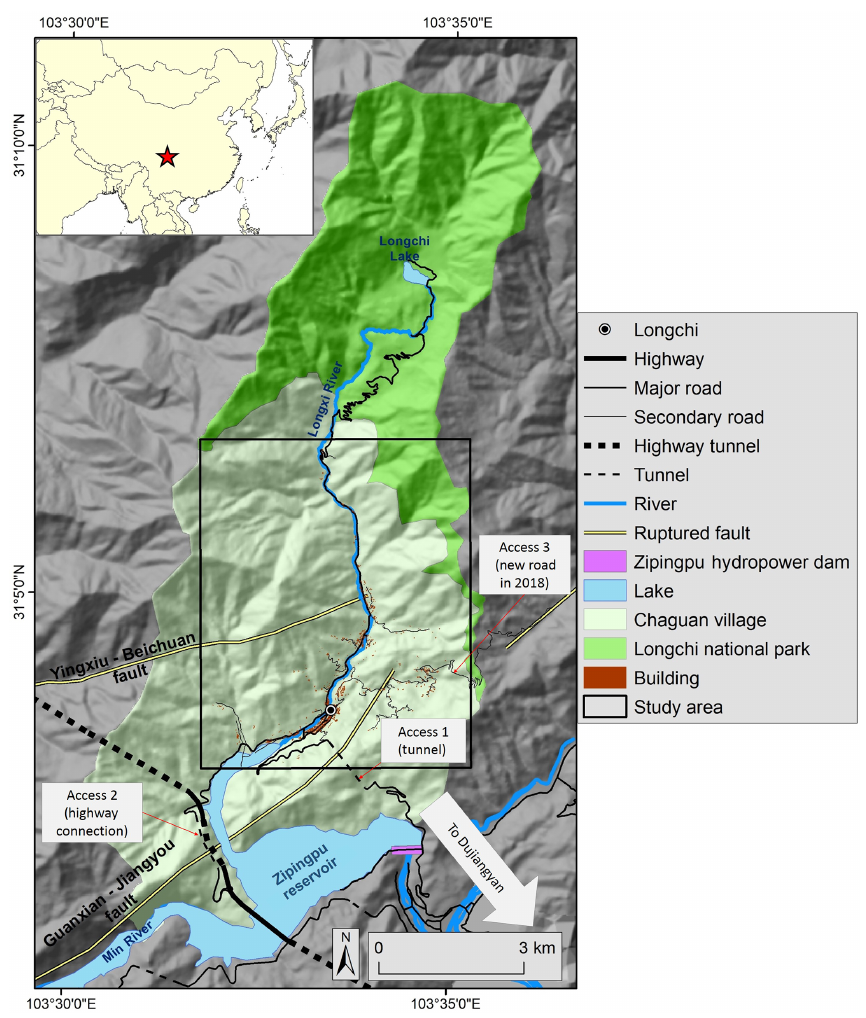
Figure 1. The location of the study area in the Longxi watershed, which contains most of the buildings in the watershed. The roads and buildings reflect the situation in 2018. Buildings outside the study area polygon were not mapped. The inset shows the study area’s location within